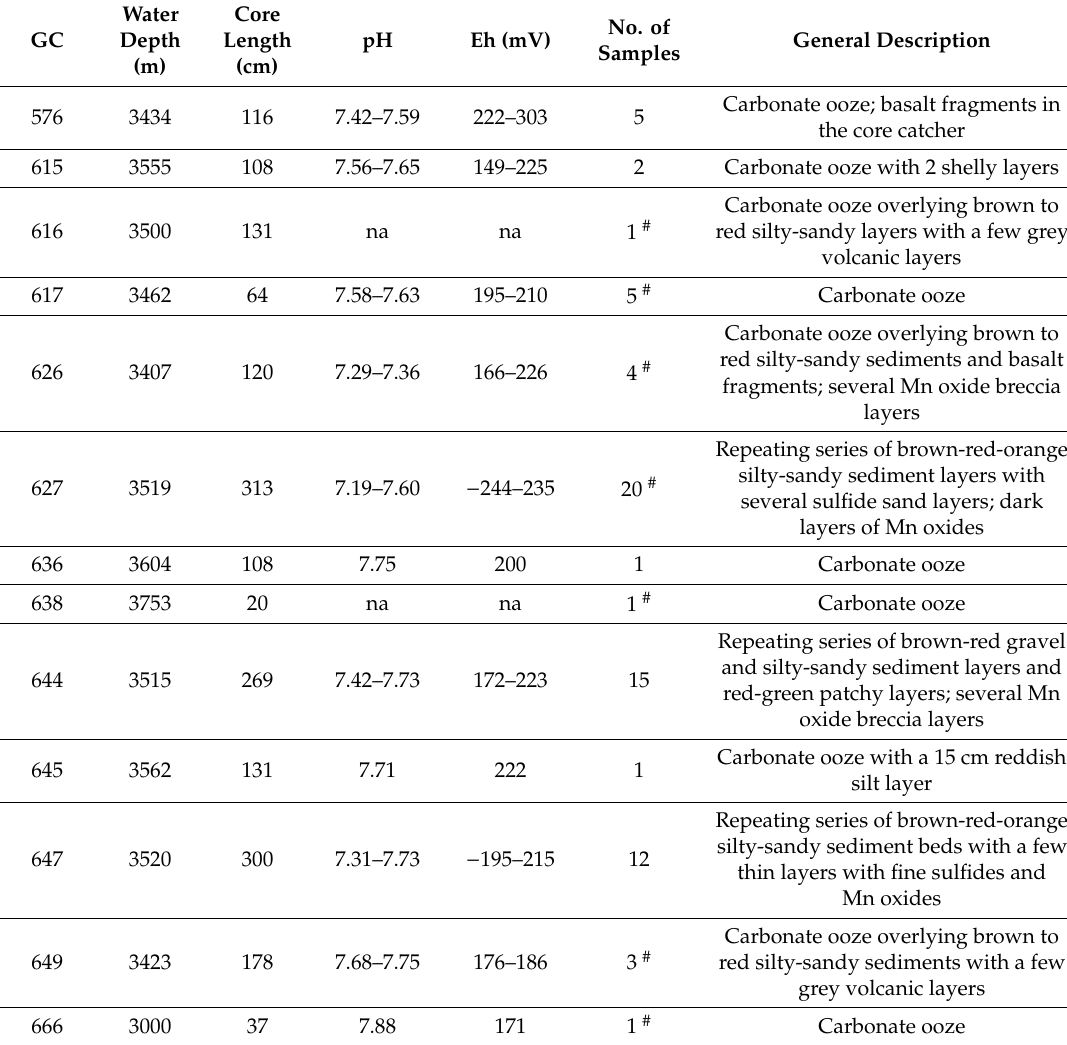
Table 1. Description and main physicochemical properties of M127 Gravity Cored (GC) sediment samples such as pH and Eh (min–max